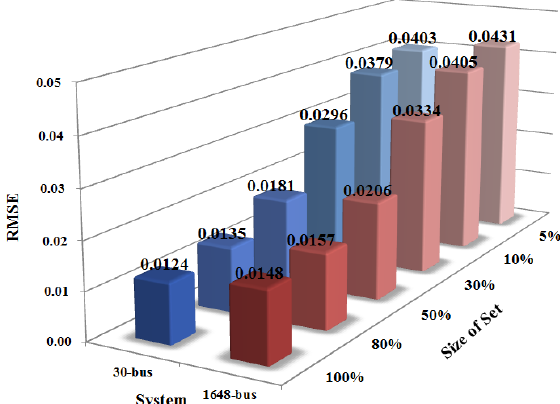
Figure 11. Assessment accuracies (root mean squared error (RMSE)) based on different training set sizes.